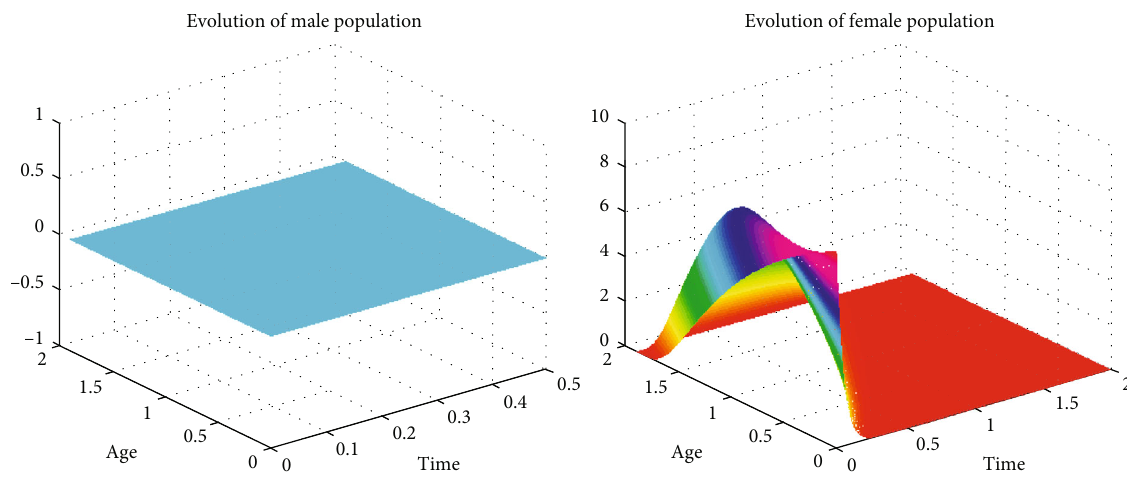
Figure 1: Evolution of the uncontrolled system from a = t = 0 to A = t = 2 .